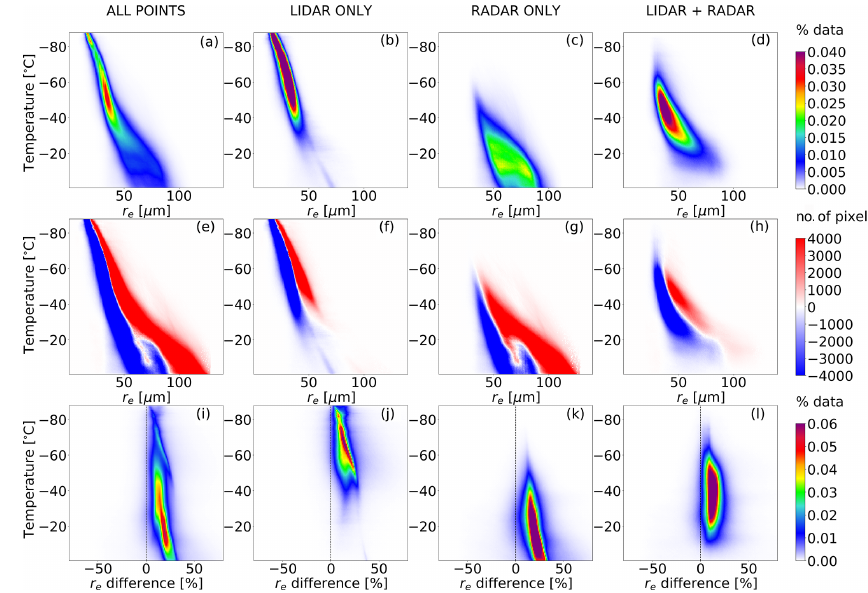
Figure 12. Comparison of the retrieved effective radius ( r e ) between V 2 and V 3 : same panels as for Fig.